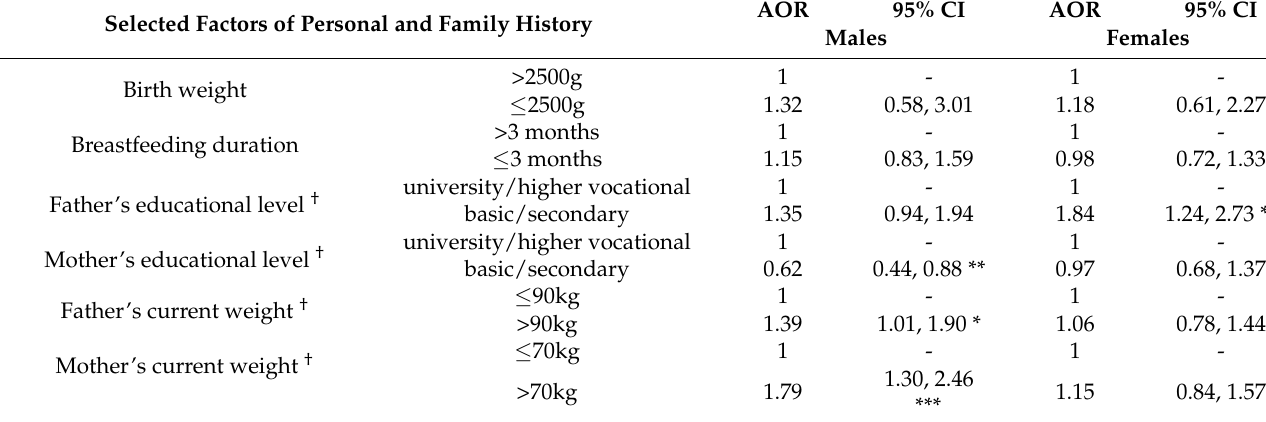
Table 5. Selected variables of adolescents’ personal and family history associated with insulin resistance (defined according to HOMA-IR) in males (n = 1205) and females (n = 1424)—multivariate logistic regression analysis.